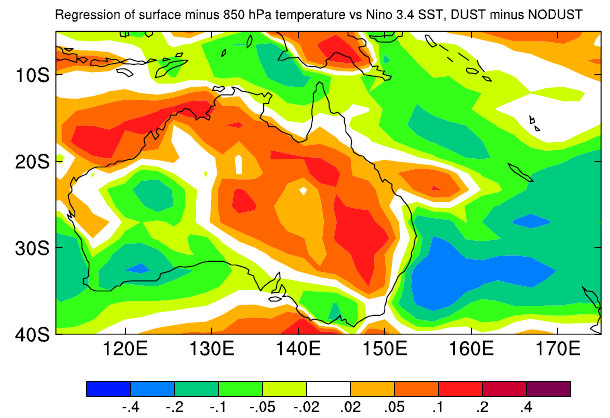
Fig. 13. Difference (DUST minus NODUST) of the slope of the regression against Ni˜no3.4 SST of surface temperature minus 850- hPa temperature for SON (in Kelvin per